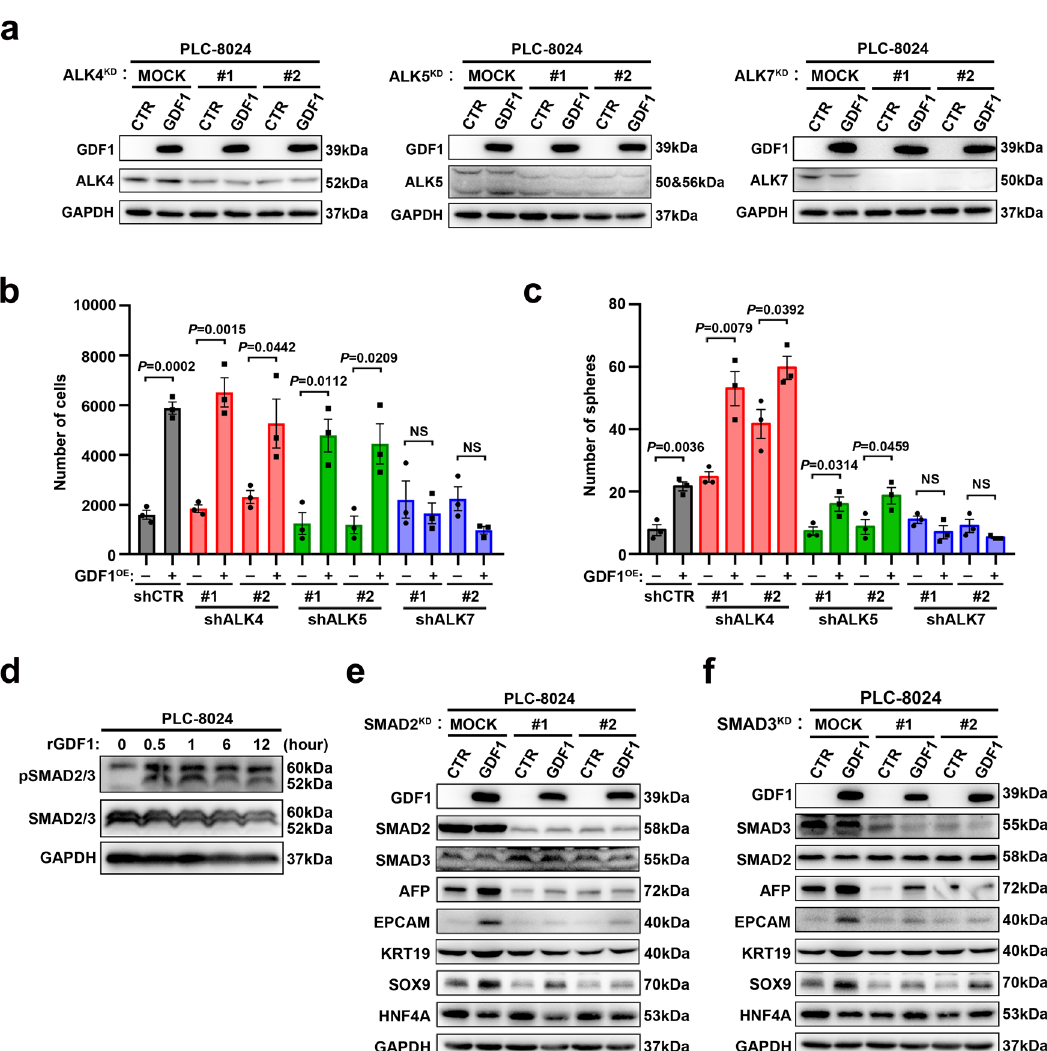
Fig. 4 GDF1 acted mainly through the ALK7 – SMAD2/3 signalling cascade. a PLC-8024 cells transfected with or without GDF1 were transduced with lentivirus-mediated shRNAs speci fi cally targeting ALK4, ALK5, and ALK7, respectively. Knockdown ef fi ciency was con fi rmed at protein level by western blot ( n = 3 independent experiments). b Cell migration assay was performed in subgroups targeting different ALKs (NS, not signi fi cant, two-tailed independent Student ’ s t test, data are presented as mean values ± SEM, n = 3 independent experiments). c Sphere-formation assay was performed in subgroups targeting different ALKs (NS, not signi fi cant, two-tailed independent Student ’ s t -test, data are presented as mean values± SEM, n = 3 independent experiments). d Recombinant GDF1 protein (50 ng/mL) was added in PLC-8024 cells, the phosphorylated and total SMAD2/3 were detected by western blot at indicated time points ( n = 3 independent experiments). e, f The liver progenitor markers and hepatic differentiation markers were examined by western blot in PLC-8024-CTR and PLC-8024-GDF1 cells transduced with lentivirus-mediated shRNAs speci fi cally targeting SMAD2 ( e ) or SMAD3 ( f ) ( n = 3 independent experiments). Source data are provided as a Source Data fi